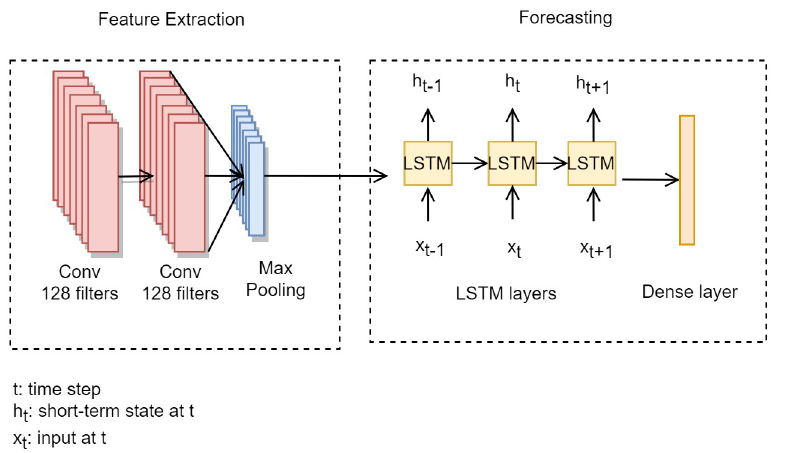
Fig 3. CNN-LSTM model